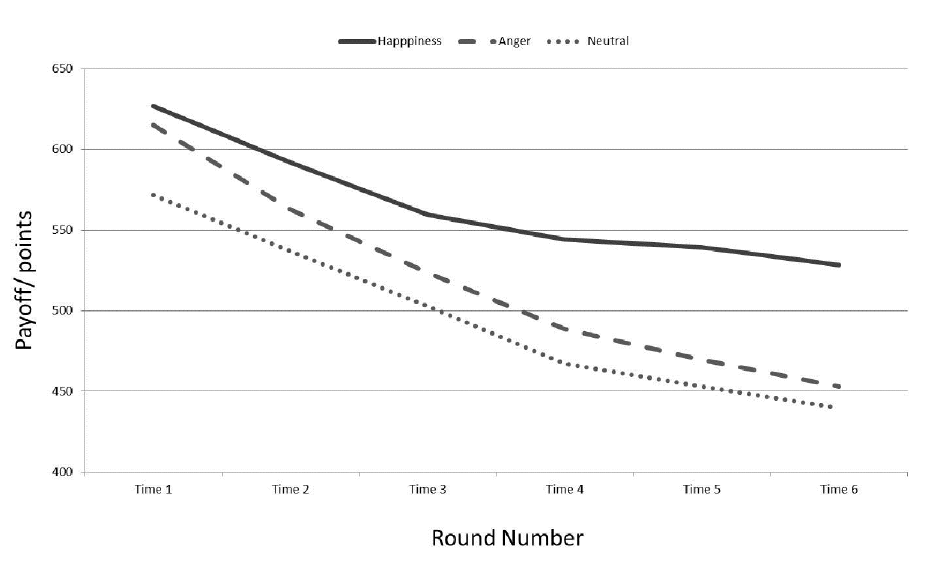
Figure 2. The effect of counterpart’s emotion on participants offer over the course of negotiation terms.